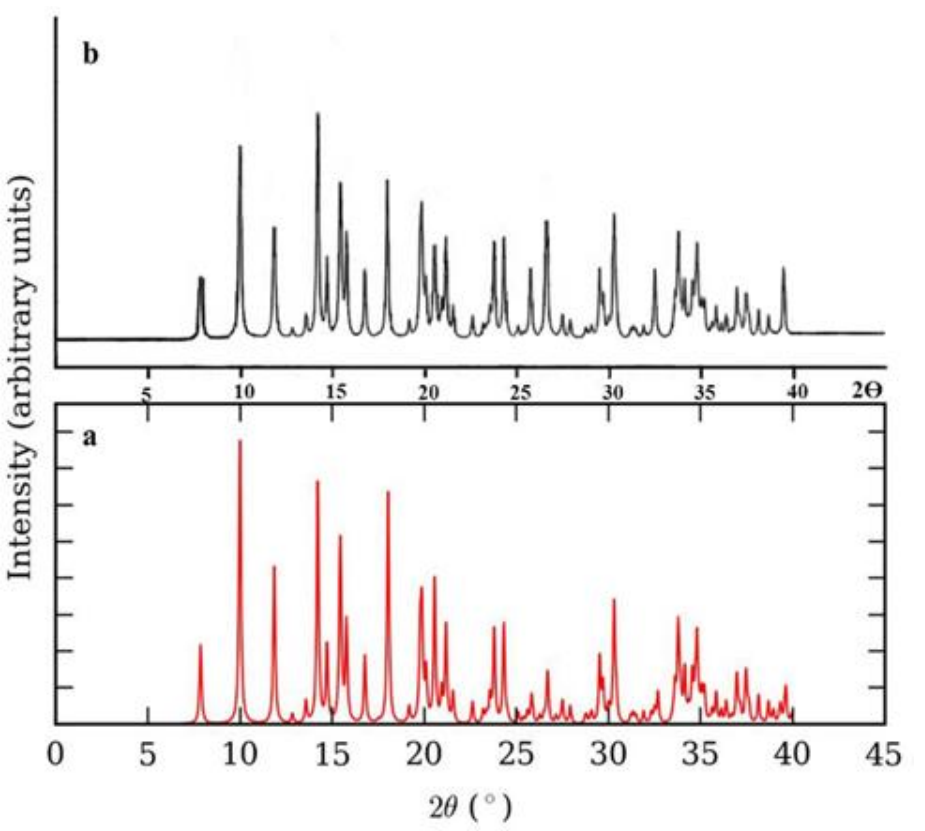
Figure 4. The XPRD designs of [Bi(HQ)(Cl) 4 ] n : ( a ) simulated from single-crystal X-ray recordings and ( b ) a nanostructure of coordination polymer produced using the sonochemical method. In Figure 5, X-ray diffraction analysis reveals that the produced coordination prod- uct in solid is a 1D coordination polymer with the ligand monodentately linked to the bismuth metal through the S atom. This compound has a Z value of 4 and is formed in a monoclinic crystal lattice. It is a member of the space group P2 1 /c.